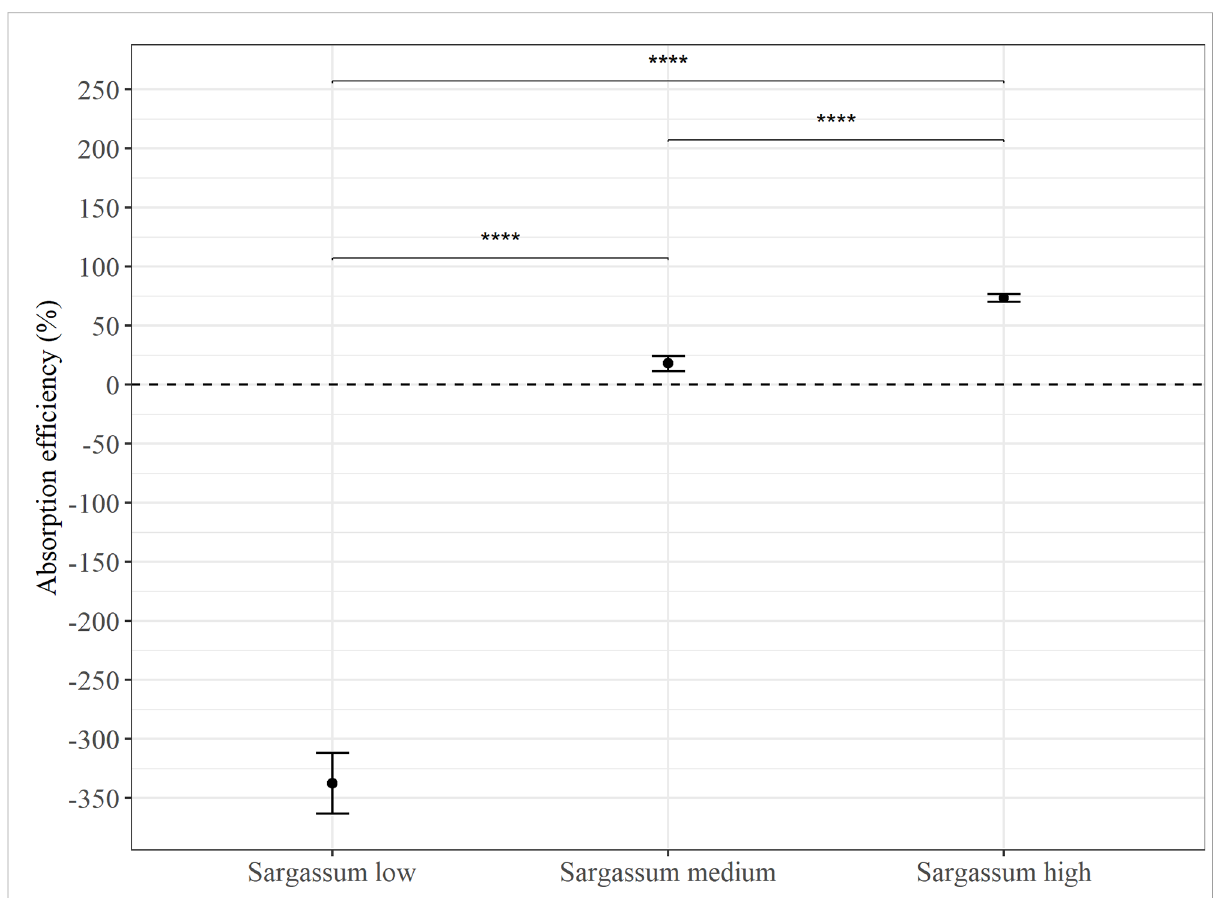
FIGURE 3 Average absorption ef fi ciency (%) in P. tremulus (n=9) given feeds with three different levels of Sargassum powder (low: 25%, medium: 50% and high: 75% v:v) over a 10-day period in Experiment 1. Error bars show standard error (se) and signi fi cant differences between feeds are indicated with asterisks (****: p ≤